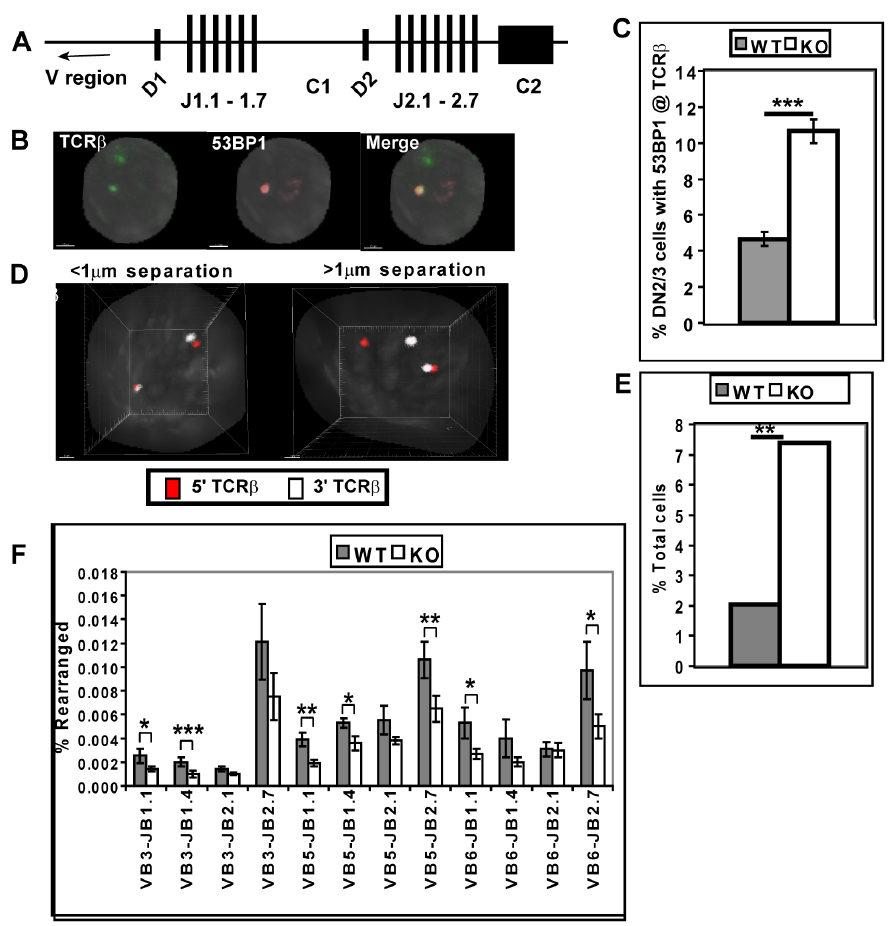
Figure 1. Rearrangement of TCR b is impaired in ATMKO DN2/3 cells. (A) Genomic organization of the murine TCR b locus. (B) A representative immuno-FISH image of an ATMKO DN2/3 cell showing a 53 BP1 focus (red) at one of two TCR b loci (green). White bar denotes 1.5 micron. (C) Graph shows mean frequency ( 6 SEM) of ATMWT (WT) and ATMKO (KO) DN2/3 cells expressing 53 BP1 foci at the TCR b locus. 200 cells of each genotype were analyzed in two experiments. (D) Representative 3D-FISH images of two ATMKO DN2/3 cells hybridized with 5 9 TCR b (red) and 3 9 TCR b probes (white). In left image probes are separated by less than 1 m m at both TCR b loci; whereas, in right image probes are separated by more than 1 m m at one of two TCR b loci. (E) Summary of the frequency of ATMWT and KO DN2/3 cells in which the 5 9 and 3 9 TCR b probes are separated by more than 1 m m one of two TCR b loci. More than 300 cells of each genotype were collected in two experiments. (F) V b -DJ b rearrangement in genomic DNA from ATMWT and KO DN2/3 cells was quantified using real-time PCR and normalized to invariant C a . This plot is mean V b -DJ b rearrangements 6 SEM of seven ATMWT and KO data sets analyzed in five real-time PCR experiments. P values: Student’s unpaired (C) and paired (F) 1- tailed t-test and Fisher’ exact test (E). *p , 0.05; ** , 0.01, ***p ,